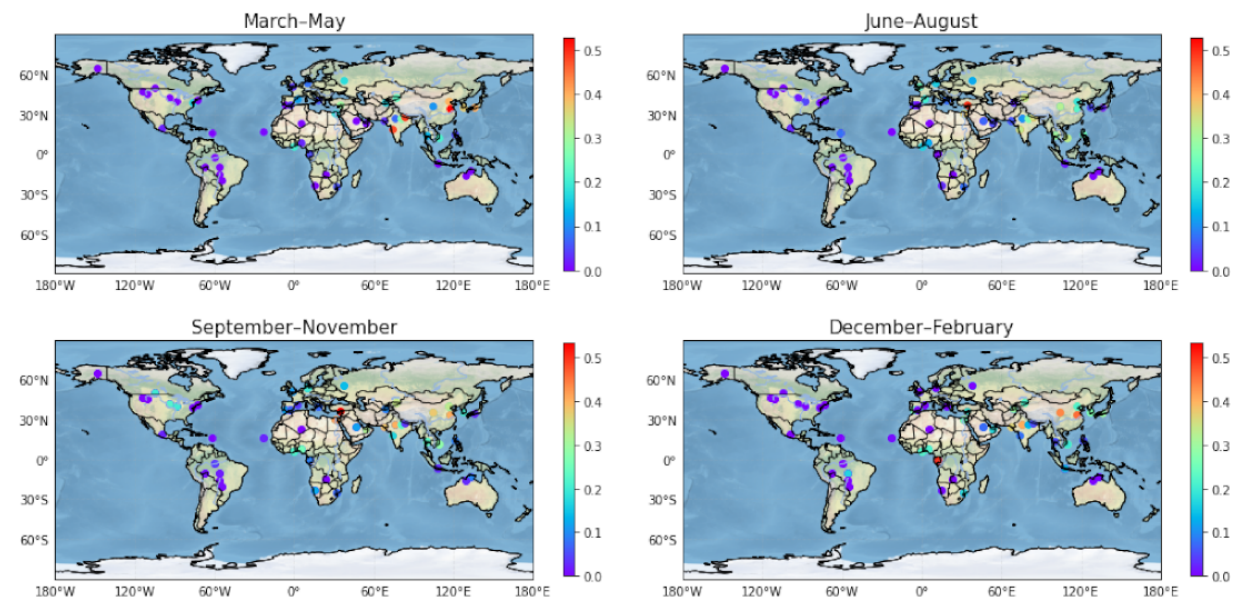
Figure 5. Temporal distribution of pollution dominated mixture. The color dot in each station implies the values of occurrence frequency in the color